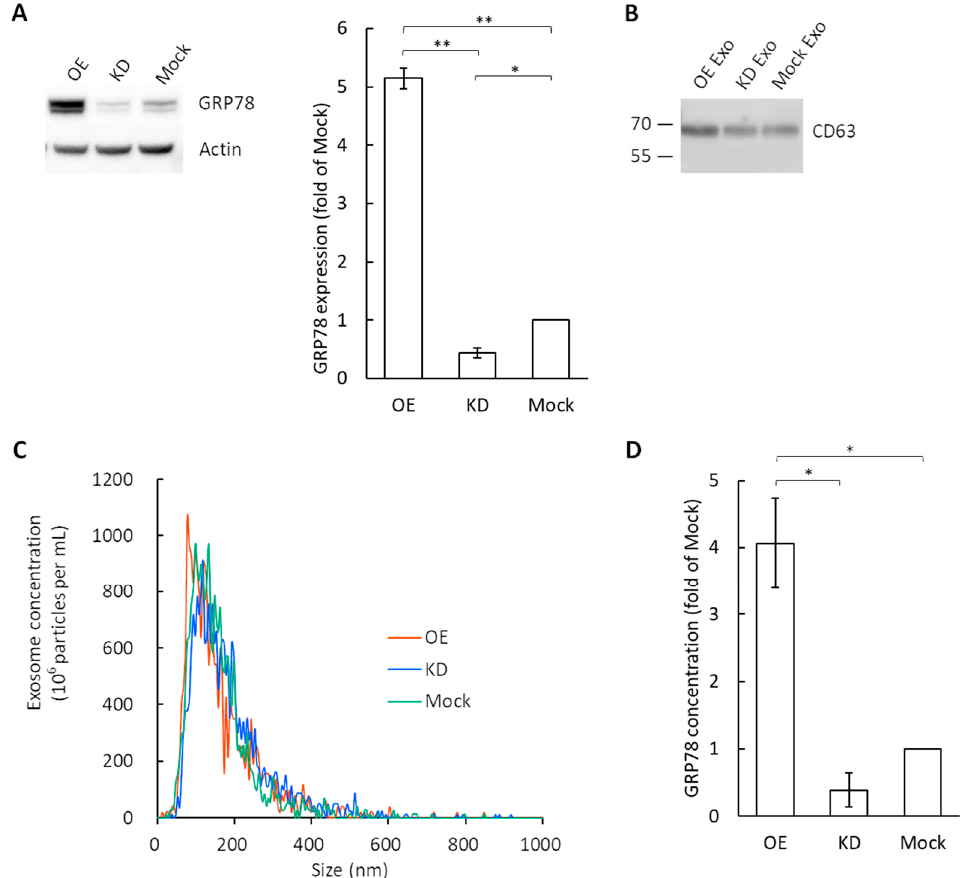
Figure 1. Characterization of exosomes isolated from the cell culture media of transfected gastric cancer AGS cells using a combination of a polymer precipitation method and an ultra-filtration method. ( A ) Western blotting of GRP78 in GRP78-OE, GRP78-KD, and GRP78-mock cells of AGS. Actin was used as the control. ( B ) Western blotting of an exosome-marker protein, CD63, for the exosomes collected from GRP78 overexpression (OE), knockdown (KD), and mock cells of AGS. ( C ) Exosome size distribution was determined by ZetaView. The peak values were around 124 nm in GRP78-OE cells, 118 nm in GRP78-KD cells, and 132 nm in GRP78-mock cells. ( D ) Comparison of concentrations of GRP78 in exosomes collected from GRP78-OE, -KD, and -mock cells of AGS. The data are expressed as a fold of the concentration of mock cells; * and ** indicate p < 0.05 and p < 0.01, respectively.